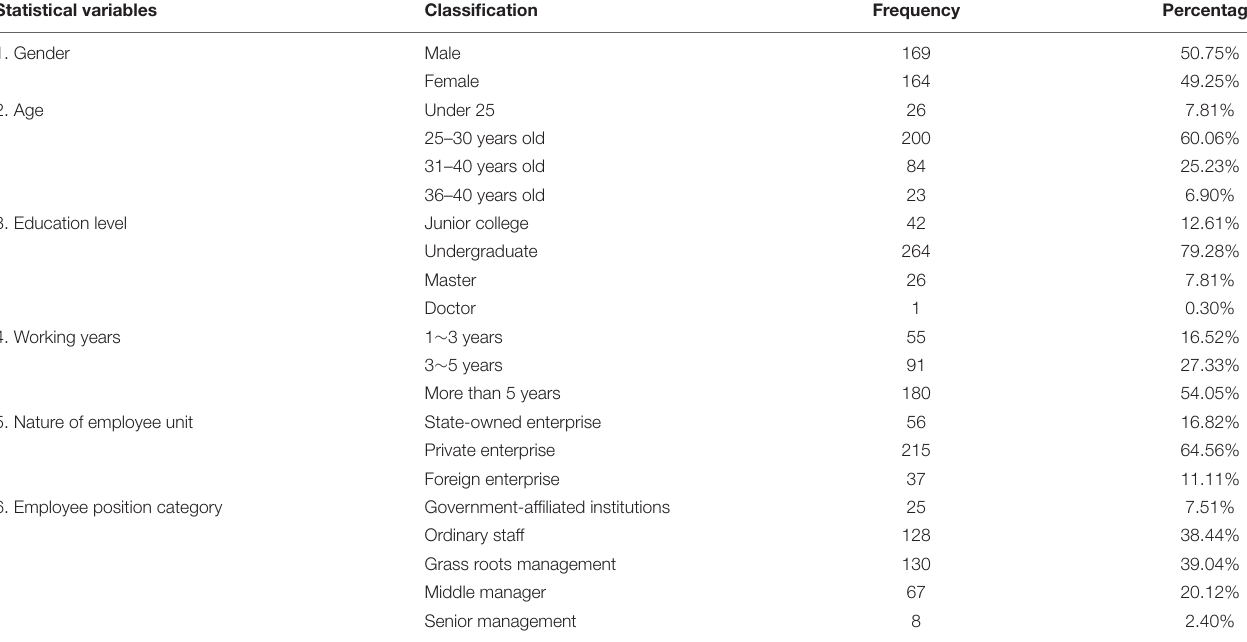
TABLE 1 | Sample demographic characteristics ( n =